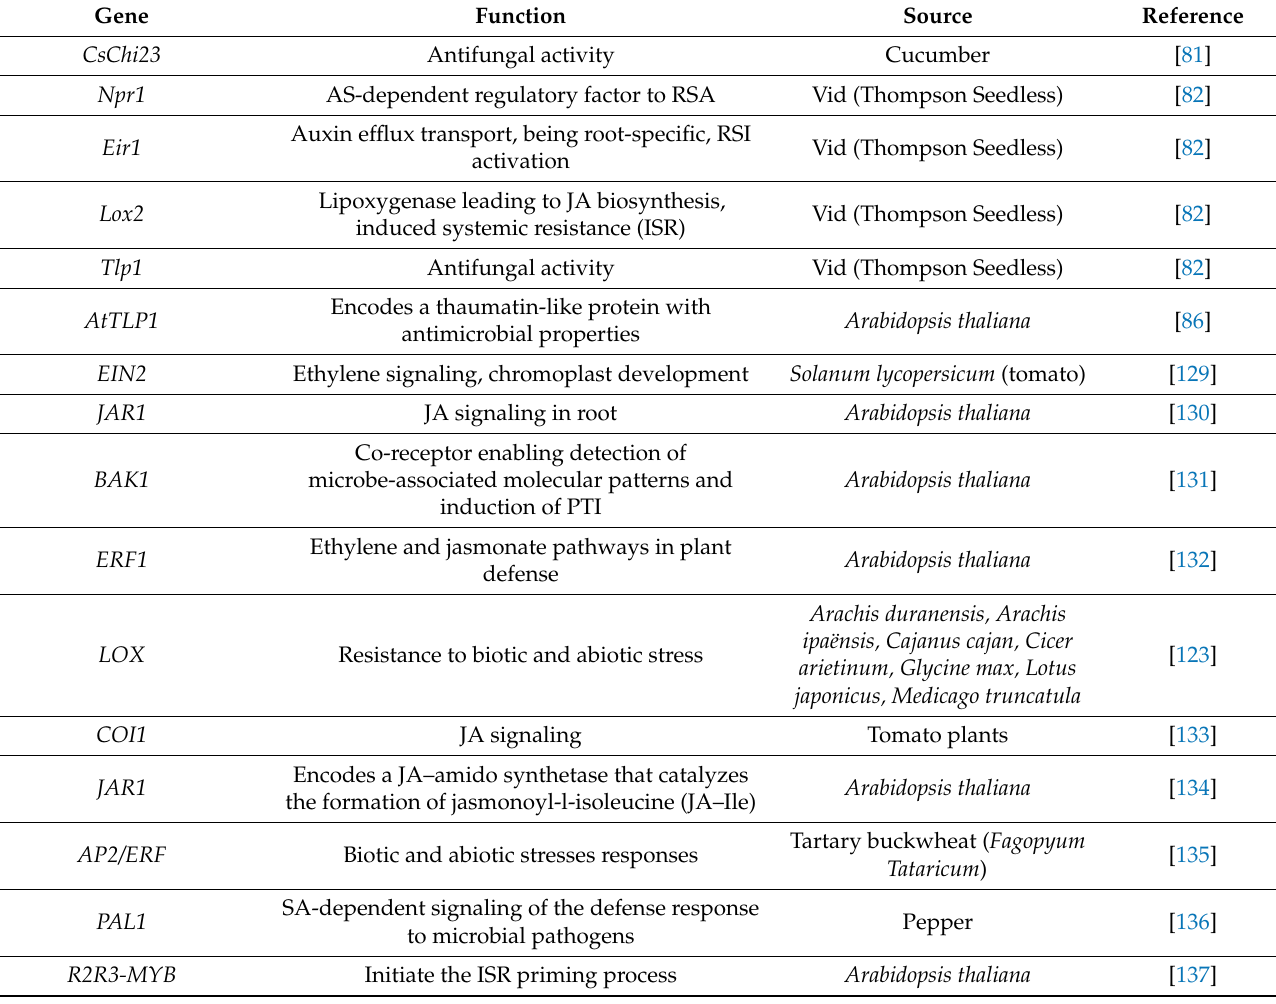
Table 3. Genes involved in plant